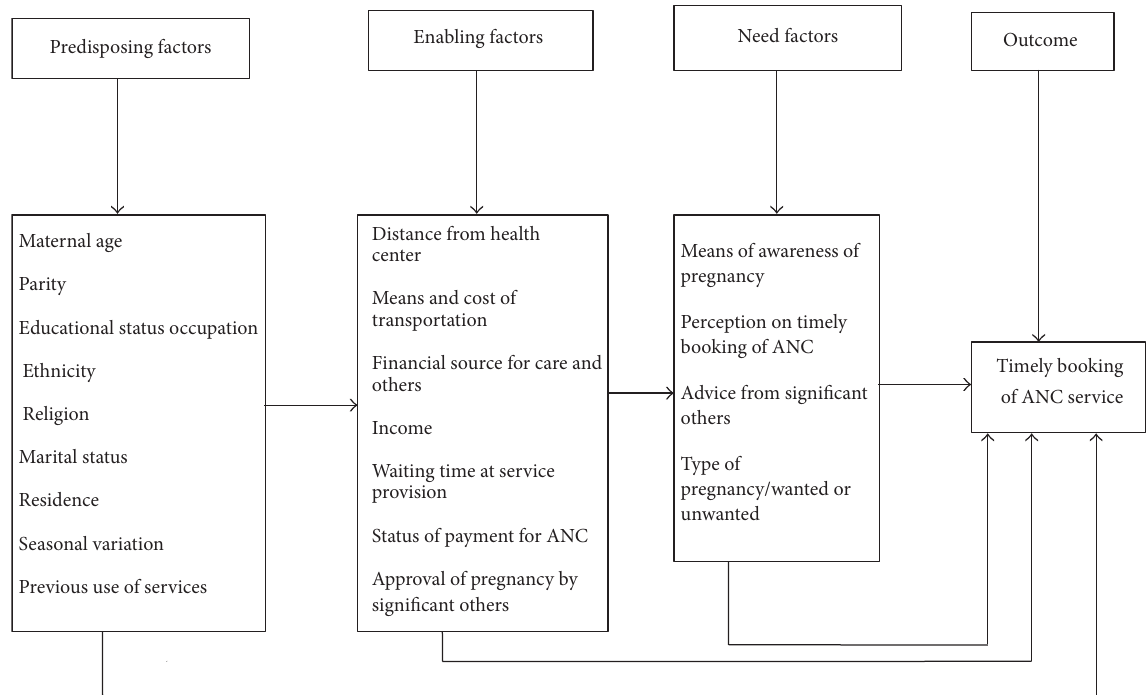
Figure 1: Conceptual framework for timely use of ANC (adapted from Anderson